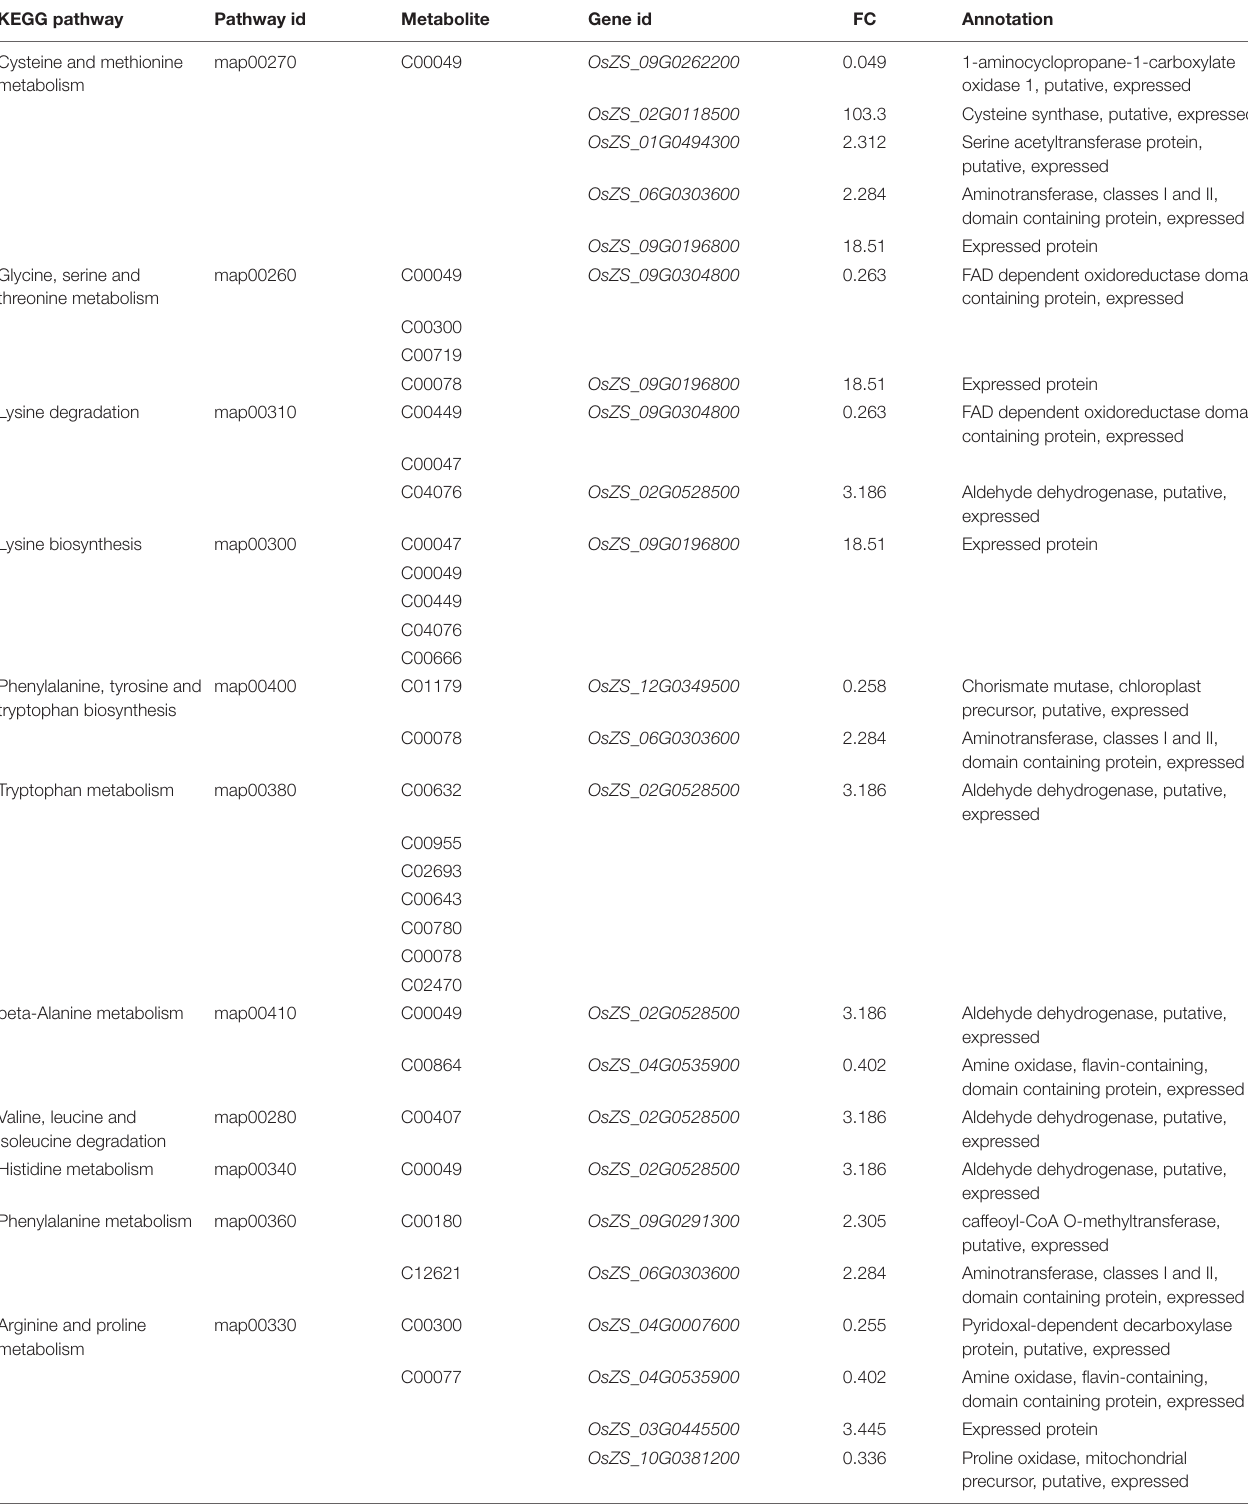
TABLE 1 | Candidate DEGs involved in KEGG pathways that are related to amino acid metabolism, energy metabolism, and lipid metabolism pathway. KEGG